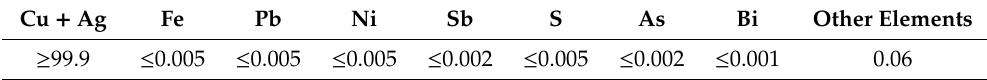
Table 2. Chemical composition of T2 copper (mass fraction,